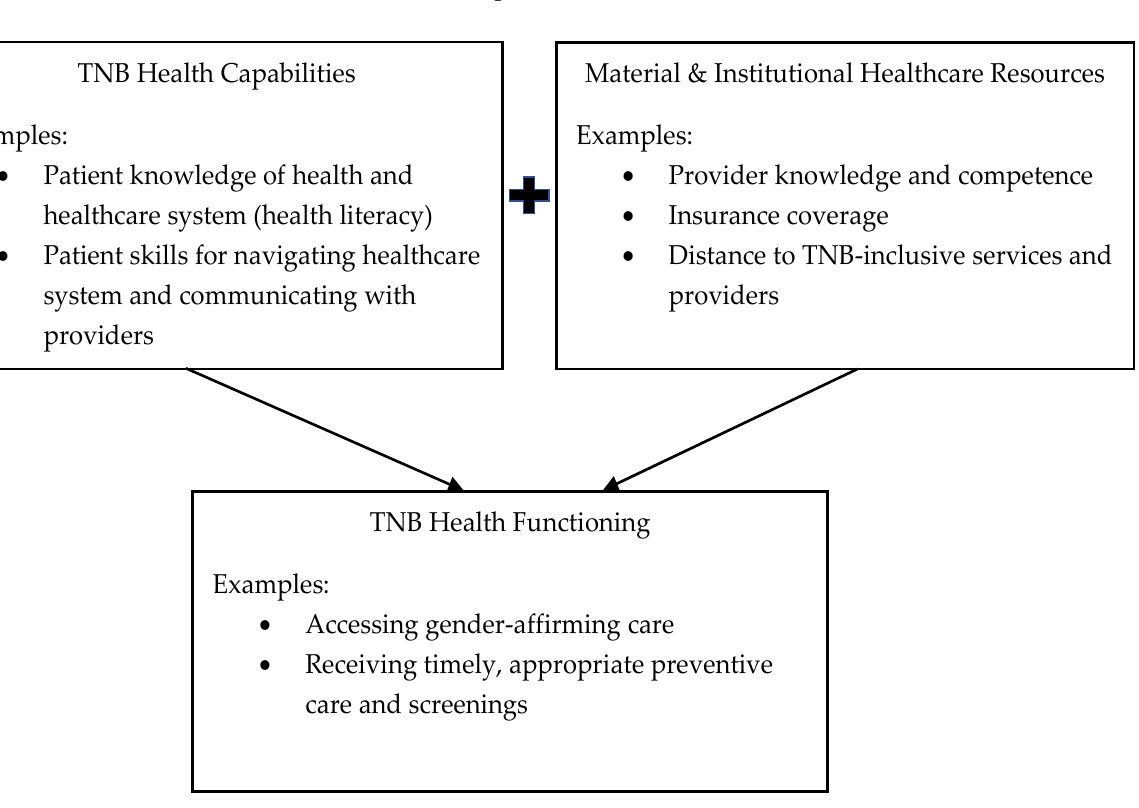
Figure 1. Capabilities framework of TNB health functioning.